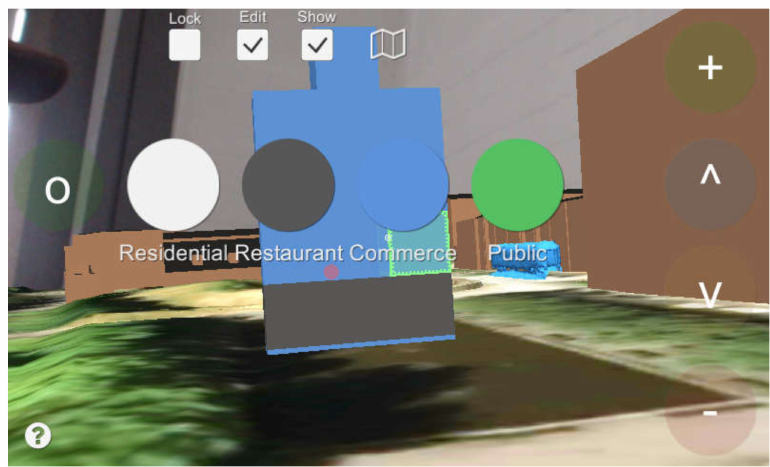
Figure 6. Building cubes of di ff erent colors representing di ff erent urban functions in P2. This figure shows a commercial building block